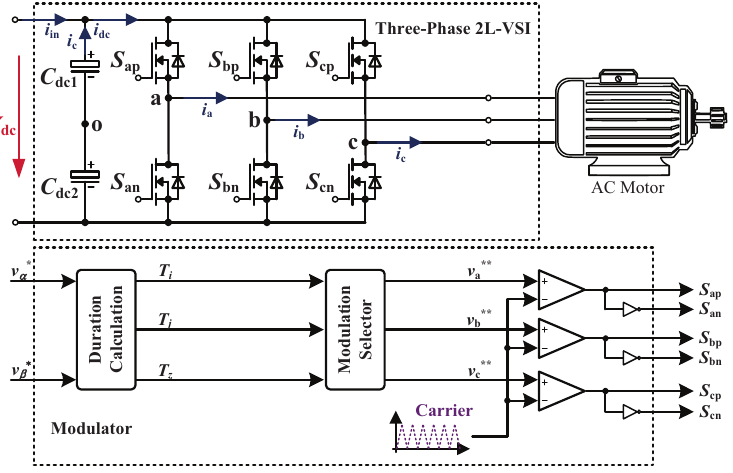
Figure 1. Circuit schematic of the three-phase three-wire